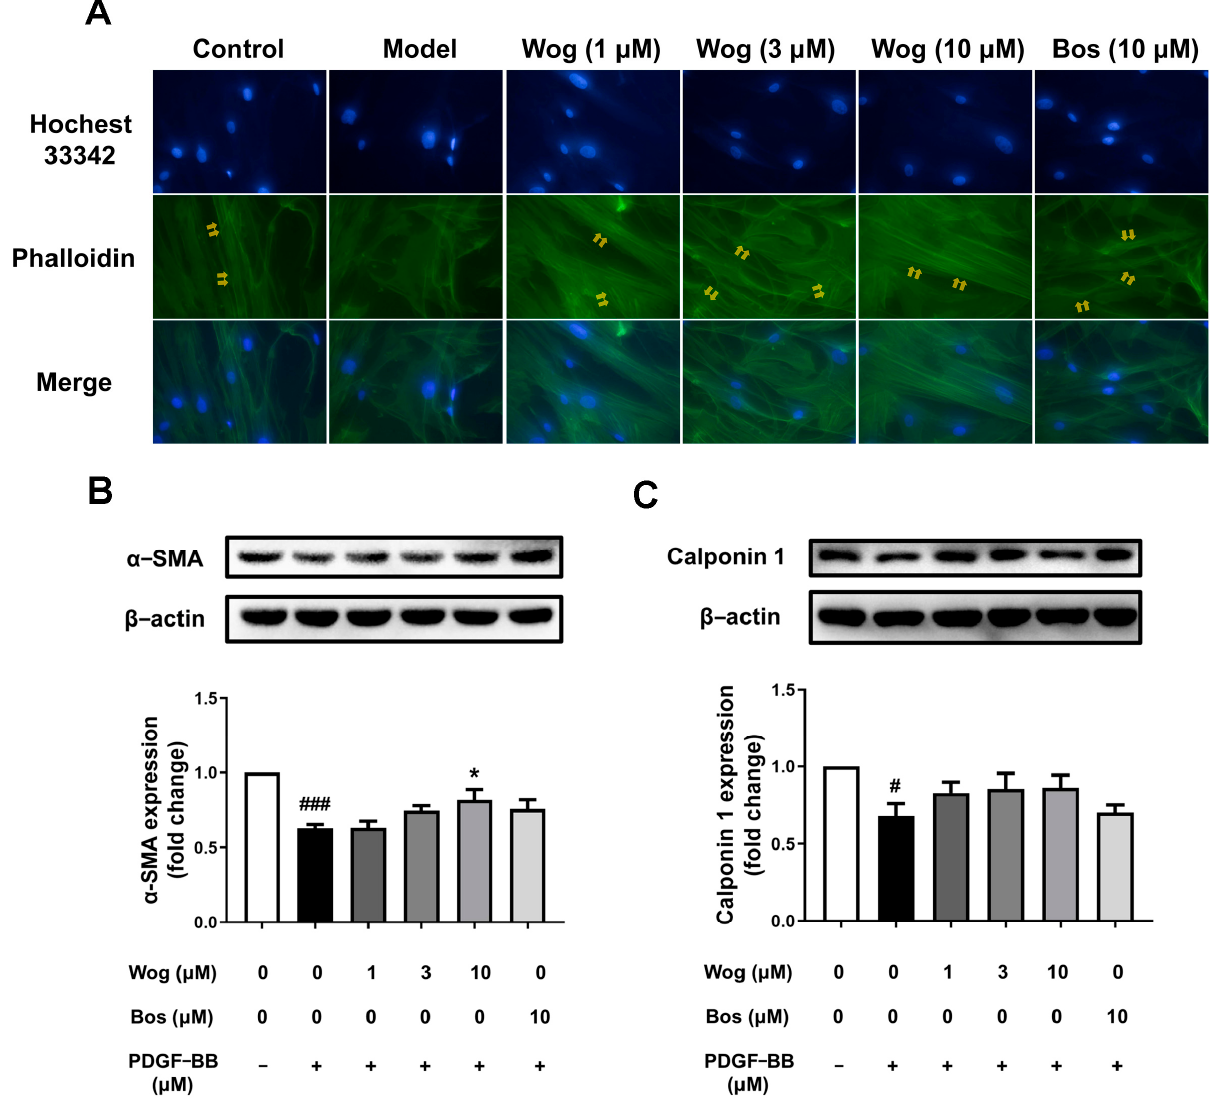
Figure 8. Effect of wogonin on phenotypic transformation of PASMCs. ( A ) The cytoskeleton is stained with phalloidin. (Original magnification ×400). Effect of wogonin on α -SMA ( B ) and calponin 1 ( C ) expression in PASMC by Western blot analysis. Results are presented as mean ± SEM (n = 3–4). # p < 0.05, ### p < 0.001 vs. control group, * p < 0.05 vs. model group.